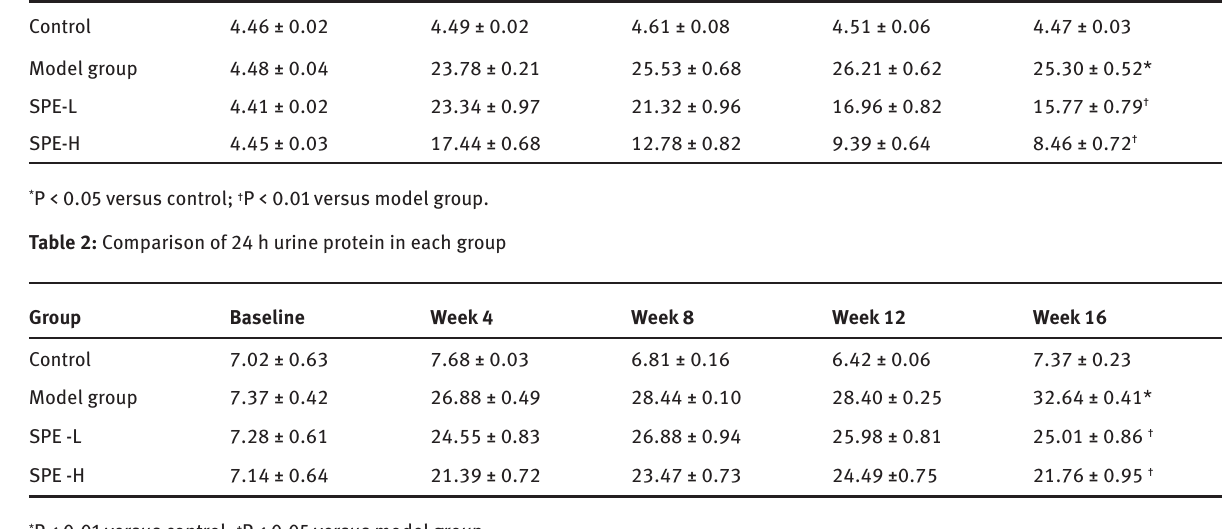
Table 1: Regulatory effects of SPE on glucose Group